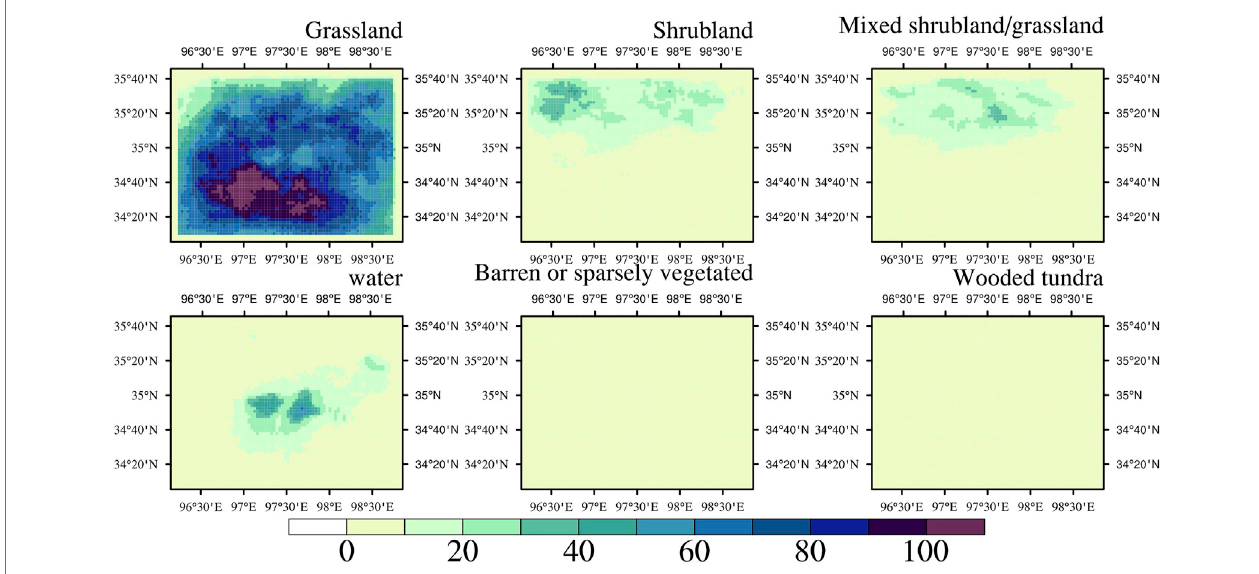
FIGURE10| Contribution oftheevapotranspirationfromdifferentunderlyingsurfacesintheYellow Riversourceareatotheprecipitationduring MaytoSeptember 2013 (unit: mm).